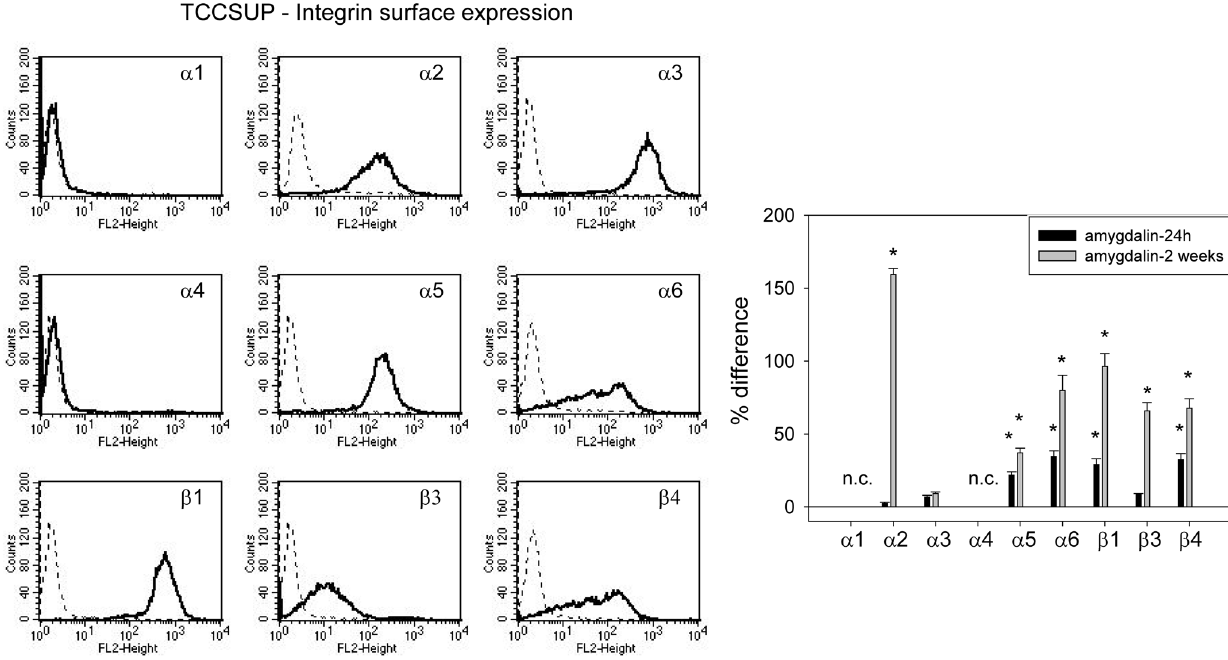
Figure 5. FACS analysis of integrin a and b subtype expression on TCCSUP cells. The left panel depicts integrin expression as histogram plots with a dotted line indicating background fluorescence and a solid line indicating specific fluorescence. The right panel shows integrin subtype expression after 24 h and 2 weeks amygdalin exposure, compared to controls set at 100%. n.c. = not calculated. * indicates significant difference to controls.